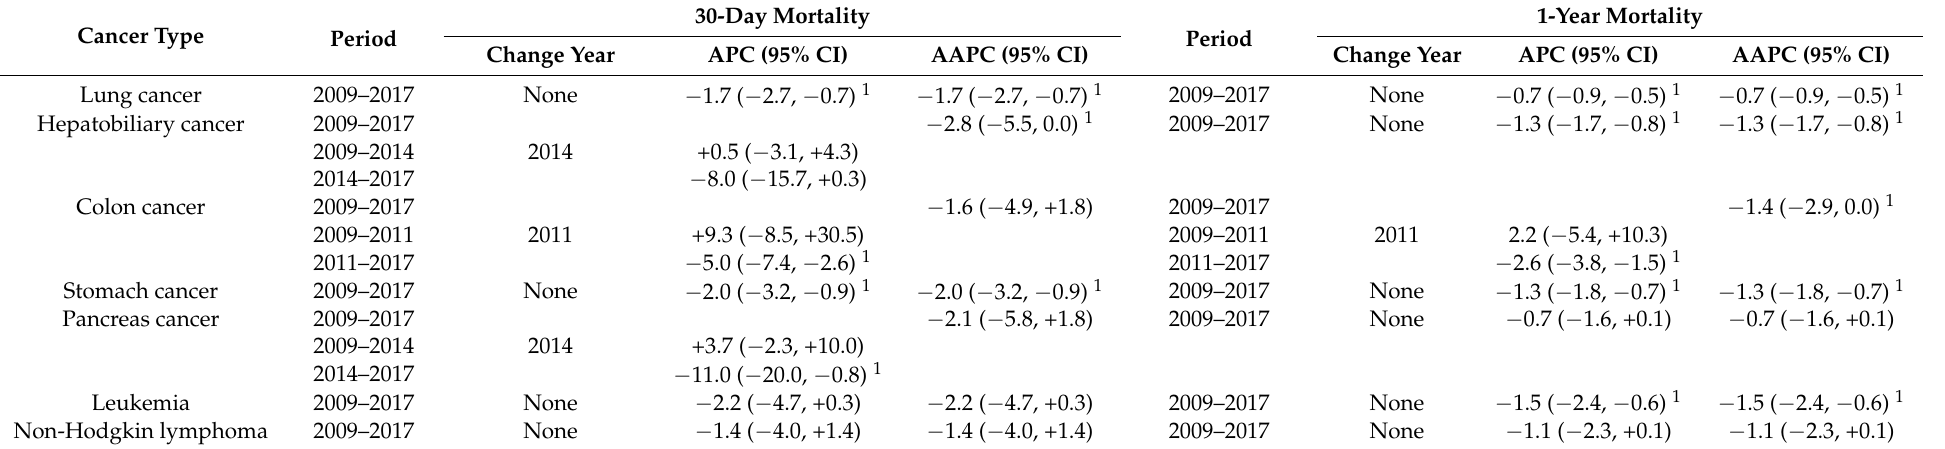
Table 3. Trends in the 30-day and 1-year mortality outcomes by cancer type among the cancer patients with septic